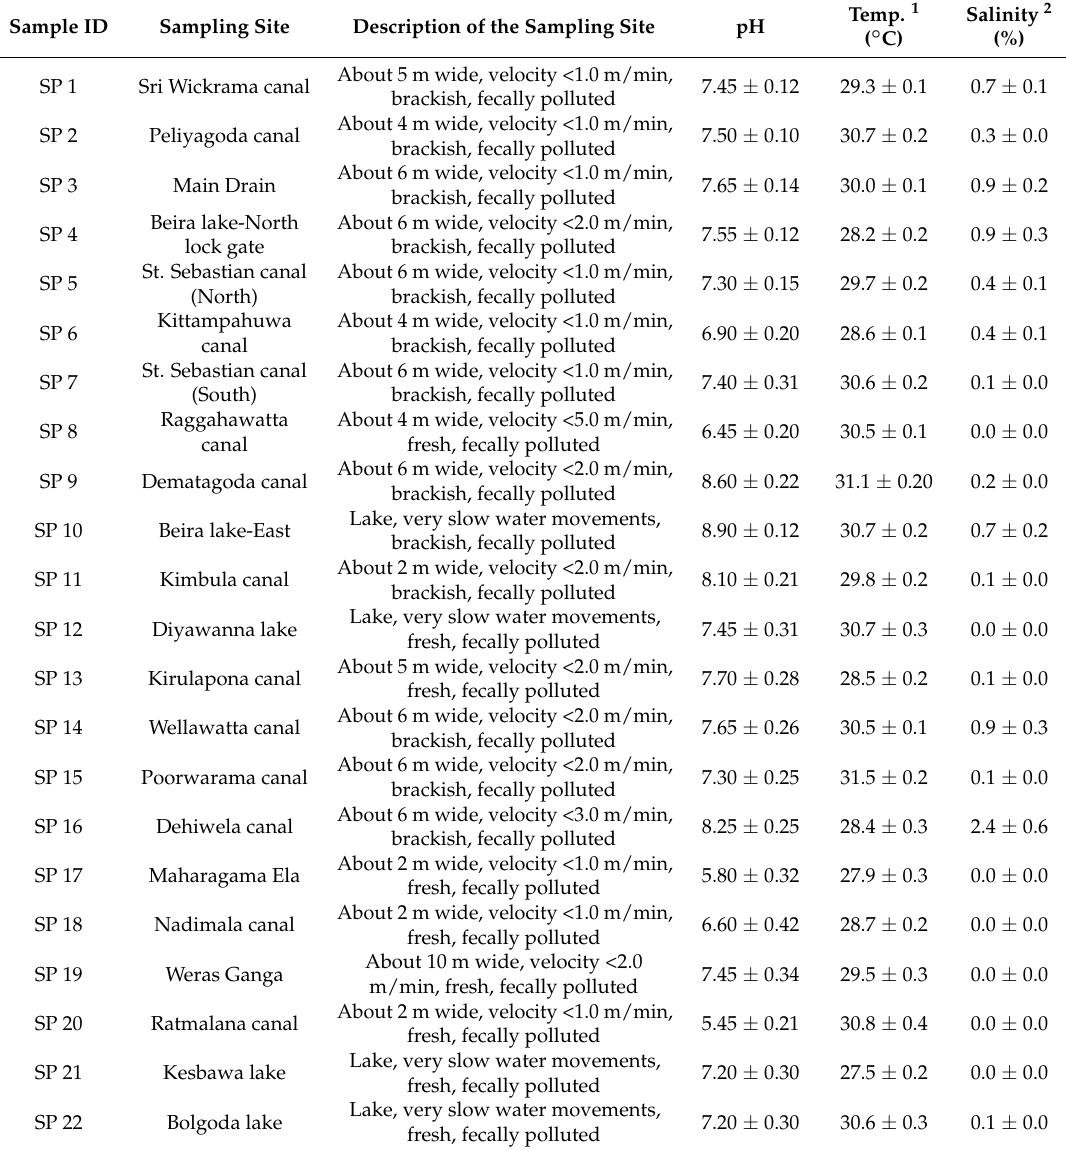
Table 1. Description of sampling locations and in situ parameters